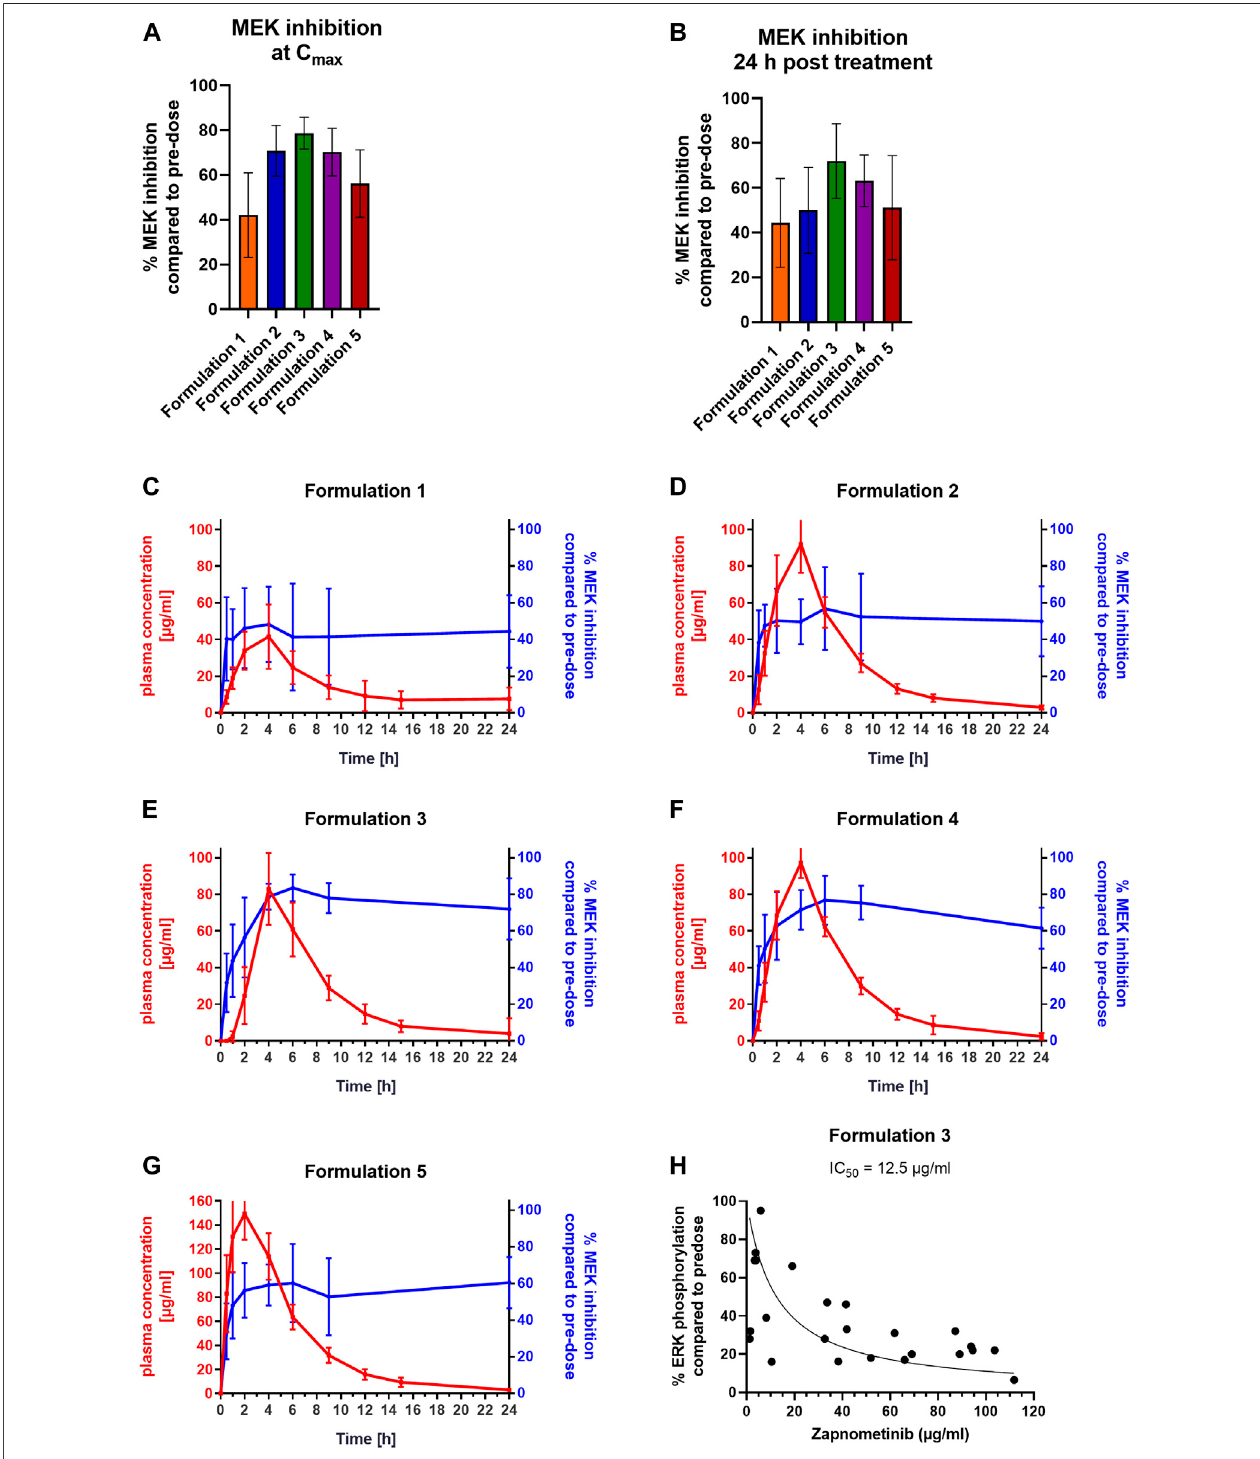
FIGURE 3 | Pharmacokinetic Pro fi les and Pharmacodynamics of Different Zapnometinib Formulations in Beagle Dogs. Beagle dogs were treated with different formulationsofzapnometinib.Bloodwastakenatpre-dose,0.5,1,2,4,6,9,12,15,and24 haftertreatmentdifferenttimepointsandanalyzedforplasmaconcentration and MEK inhibition. (A,B) PBMCsamplesofdogs (A) at thetime ofthehighest plasma concentrationC max ( t = 2or 4 h; n (formulation 1) =9; n (formulation 2) =7; n (formulation3) = 10; n (formulation4) = 8; n (formulation 5) =10) or (B) 24 hpost treatment ( n (formulation1) = 8; n (formulation2) =10; n (formulation 3) = 10; n (formulation4) =10; n (formulation 5) = 10) were